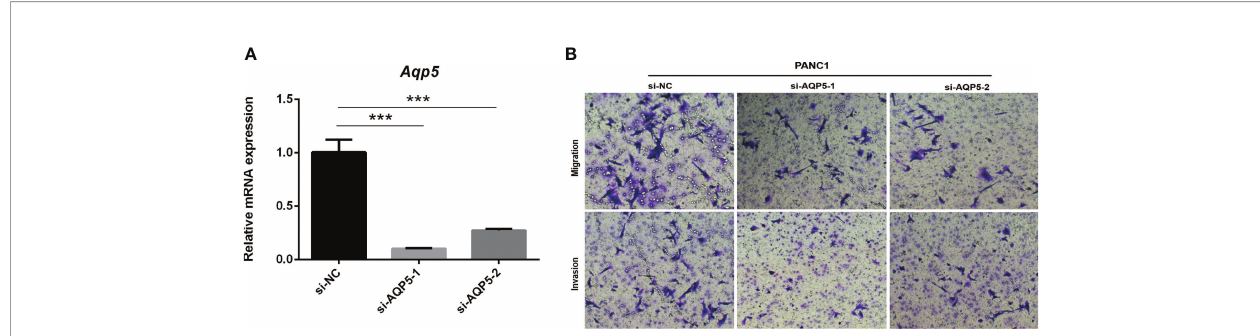
FIGURE 9 | AQP5 knockdown inhibits migration and invasion of PAAD cells in vitro . Knockdown of AQP5 signi fi cantly impaired the migration and invasion capabilities of PANC-1 cells (A, B) . *** p <